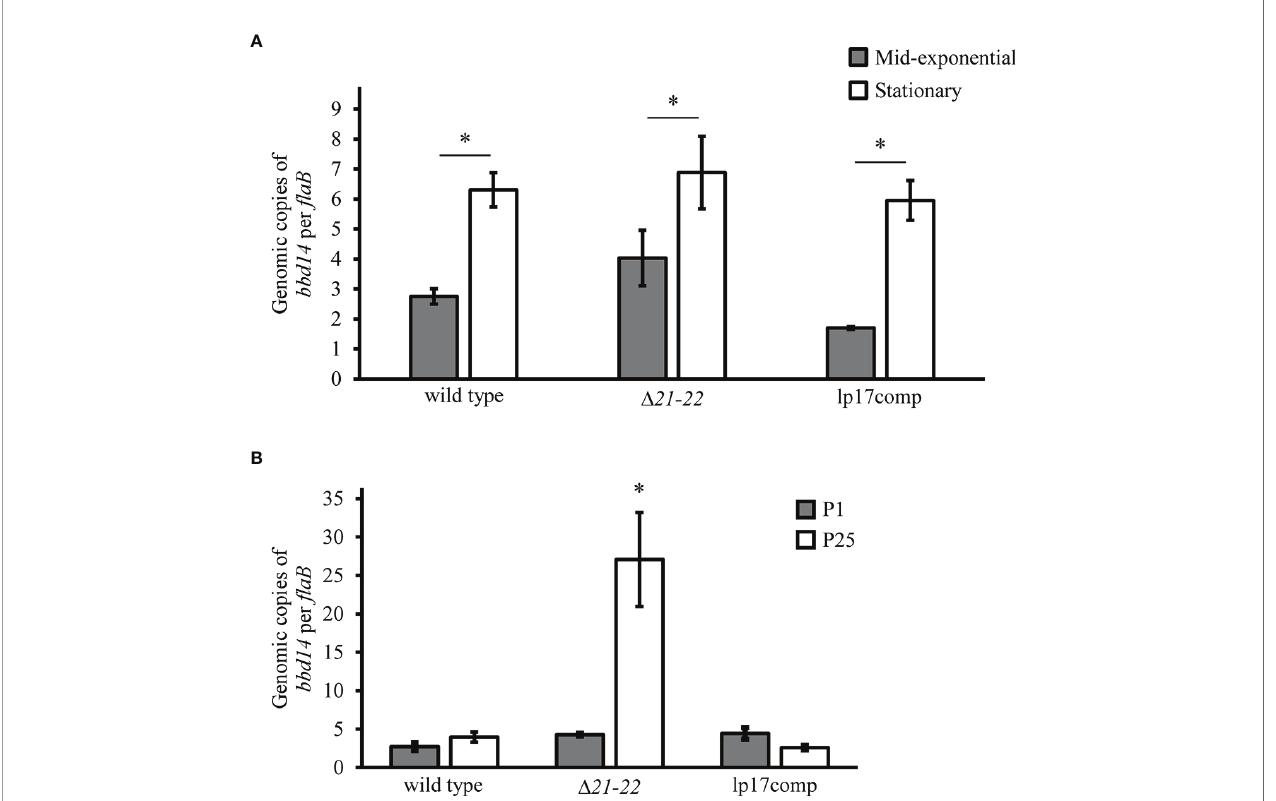
FIGURE 3 | Deletion of bbd21-bbd22 results in changes to lp17 plasmid copy number at different stages of the growth curve and following in vitro passaging. (A) Quantitative PCR analysis of genomic DNA from wild-type, D 21-22 , and lp17comp strains grown to mid-exponential phase (~2 x 10 7 cells/ml; gray bars) and stationary phase (~1.2 x 10 8 cells/ml; white bars). Bars indicate the average relative copies of bbd14 per fl aB from three experiments ± standard error mean. *p<0.05 (Student ’ s t -test). (B) in vitro Quantitative PCR of genomic DNA isolated from bacterial strains sepassaged 25 times in vitro . Three samples per strain were used, and values were expressed as averaged copies of bbd14 per fl aB ± standard error mean. Samples passaged 25 times (P25) are displayed in white bars, and those cultivated from glycerol stocks (P1) not passaged more than three times prior to the start of experiments are displayed as gray bars. Error bars represent standard error mean. *p<0.05 (Student ’ s t